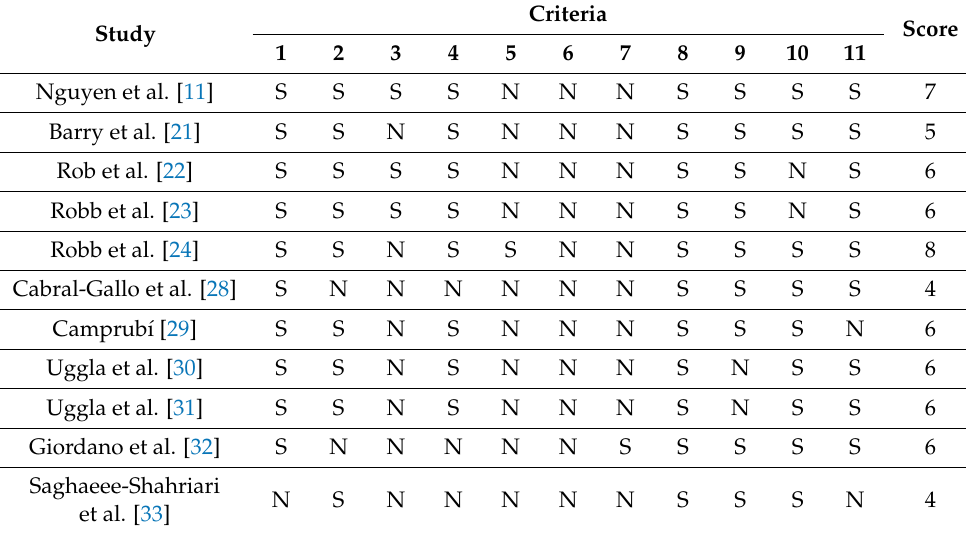
Table 2. Physiotherapy Evidence Database (PEDro)